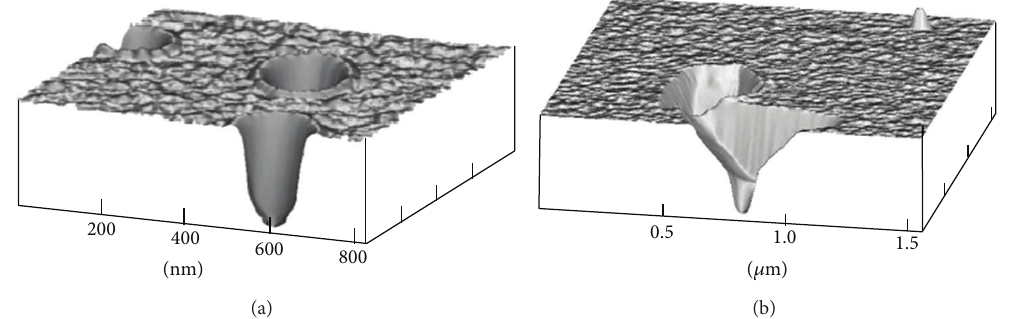
Figure 3: Characteristic crater morphologies produced by 351 nm, 0.5 ns irradiation of 18.5 nm particles lodged at different depths: (a) regular crater [40]; (b) complex crater [43].